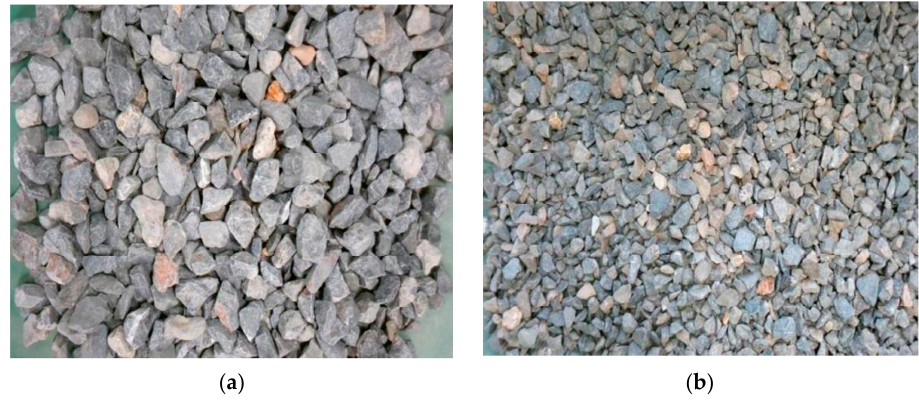
Figure 3. Stones and small stones. ( a ) Stones. ( b ) Small stones.